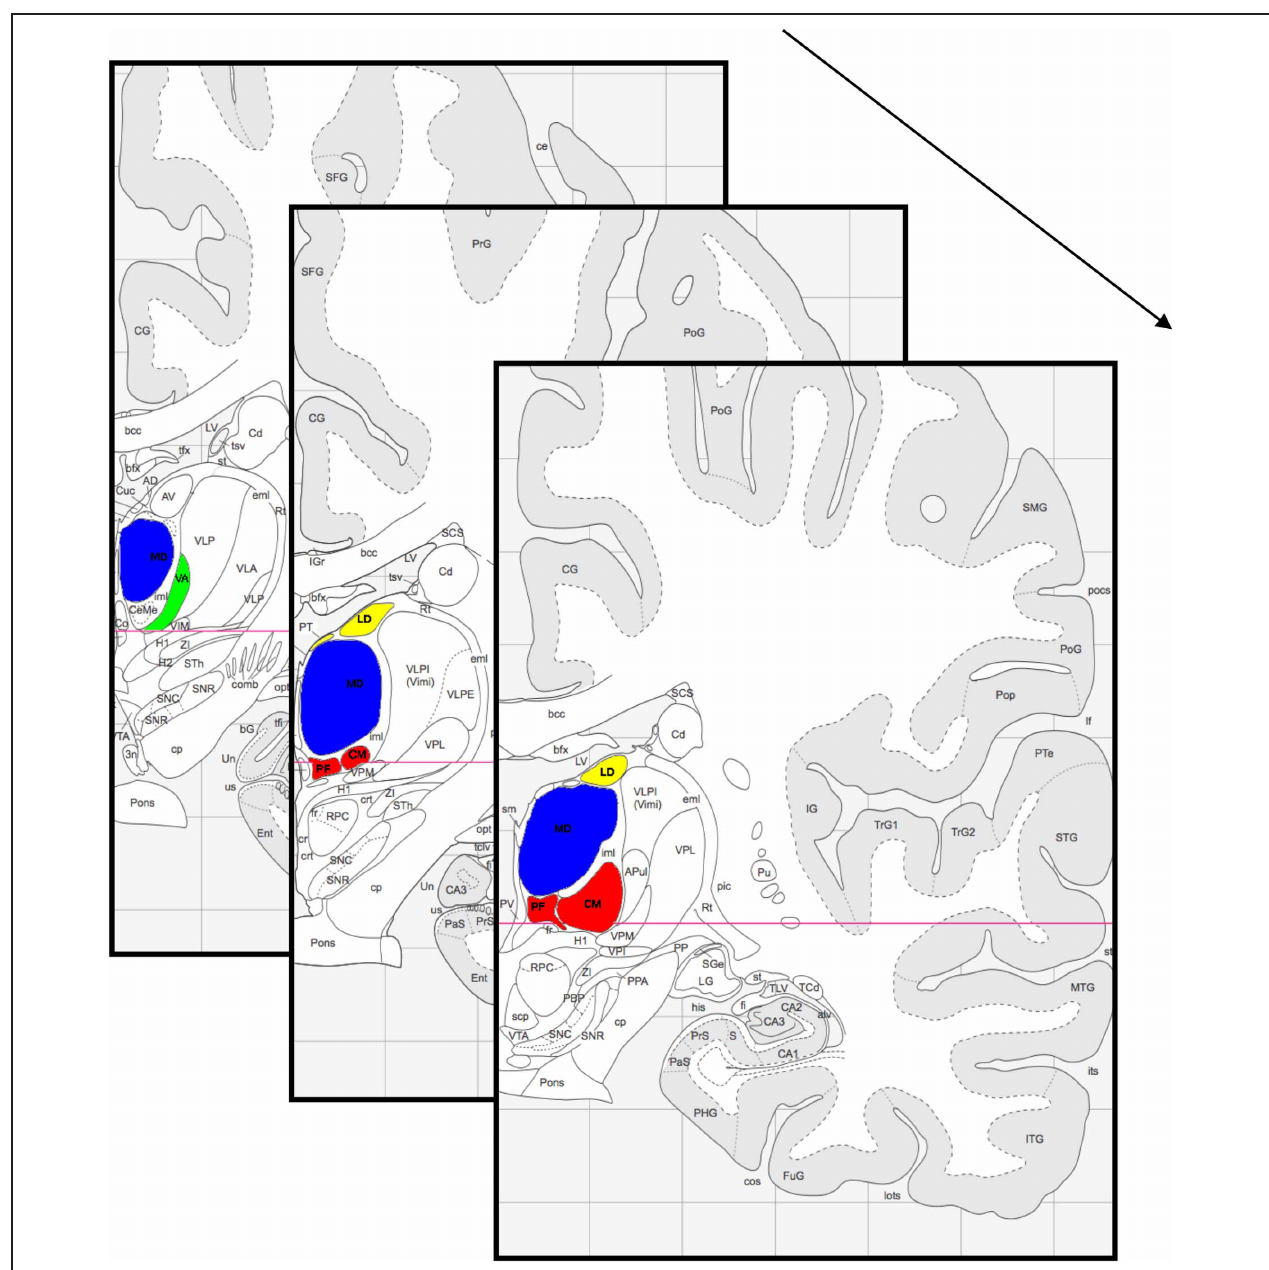
FIGURE 1 | Thalamic section from anterior (back) to posterior (front). Highlighted are the mediodorsal thalamic nucleus (blue), the centromedian/ parafascicular thalamic complex (red), the laterodorsal and parataenial thalamic nucleus (yellow) and the ventral anterior thalamic nucleus (green). Figure adapted from Mai et al.